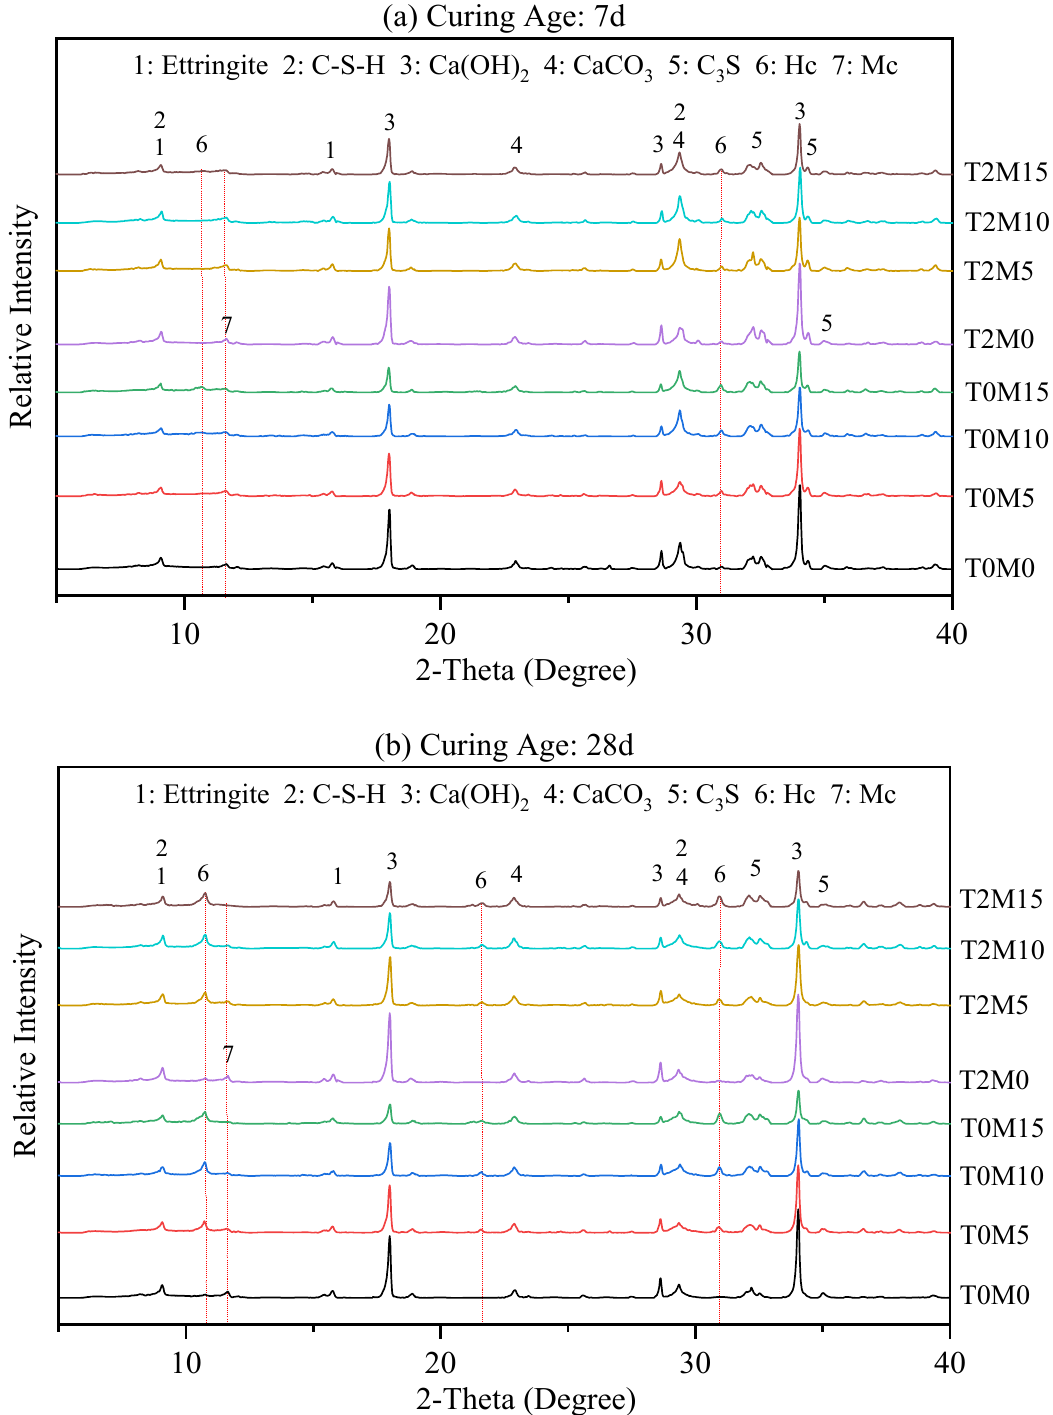
Figure 5. XRD patterns of MK blended cement pastes with the BTE at ( a ) 7 days and ( b ) 28 days. At later ages, the formation of hemicarboaluminate (Hc) was observed in MK blended system, while monocarboaluminate (Mc) was mainly observed in pure cement mortars.